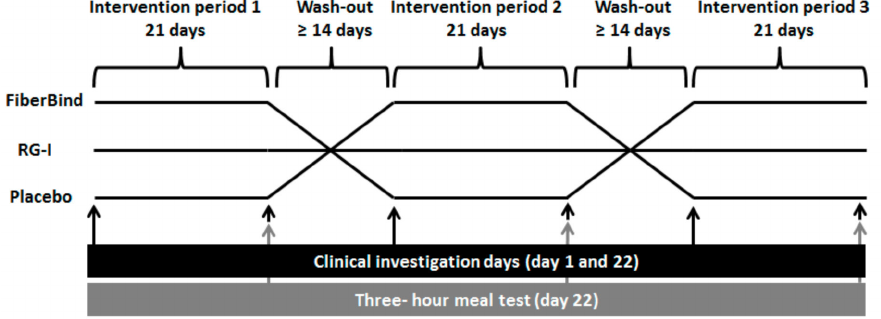
Figure 1. Study design. A randomized, three-way, crossover, placebo-controlled study with clinical investigations on Days 1 and 22 of each intervention period. RG-I, rhamnogalacturonan I. Before and after each intervention period (Days 1 and 22), after a 12 h overnight fast (0.5 L of water allowed) and a 24 h refrain from physical exercise and alcohol intake, the following were measured: body weight, blood pressure, and breath hydrogen (produced during colonic